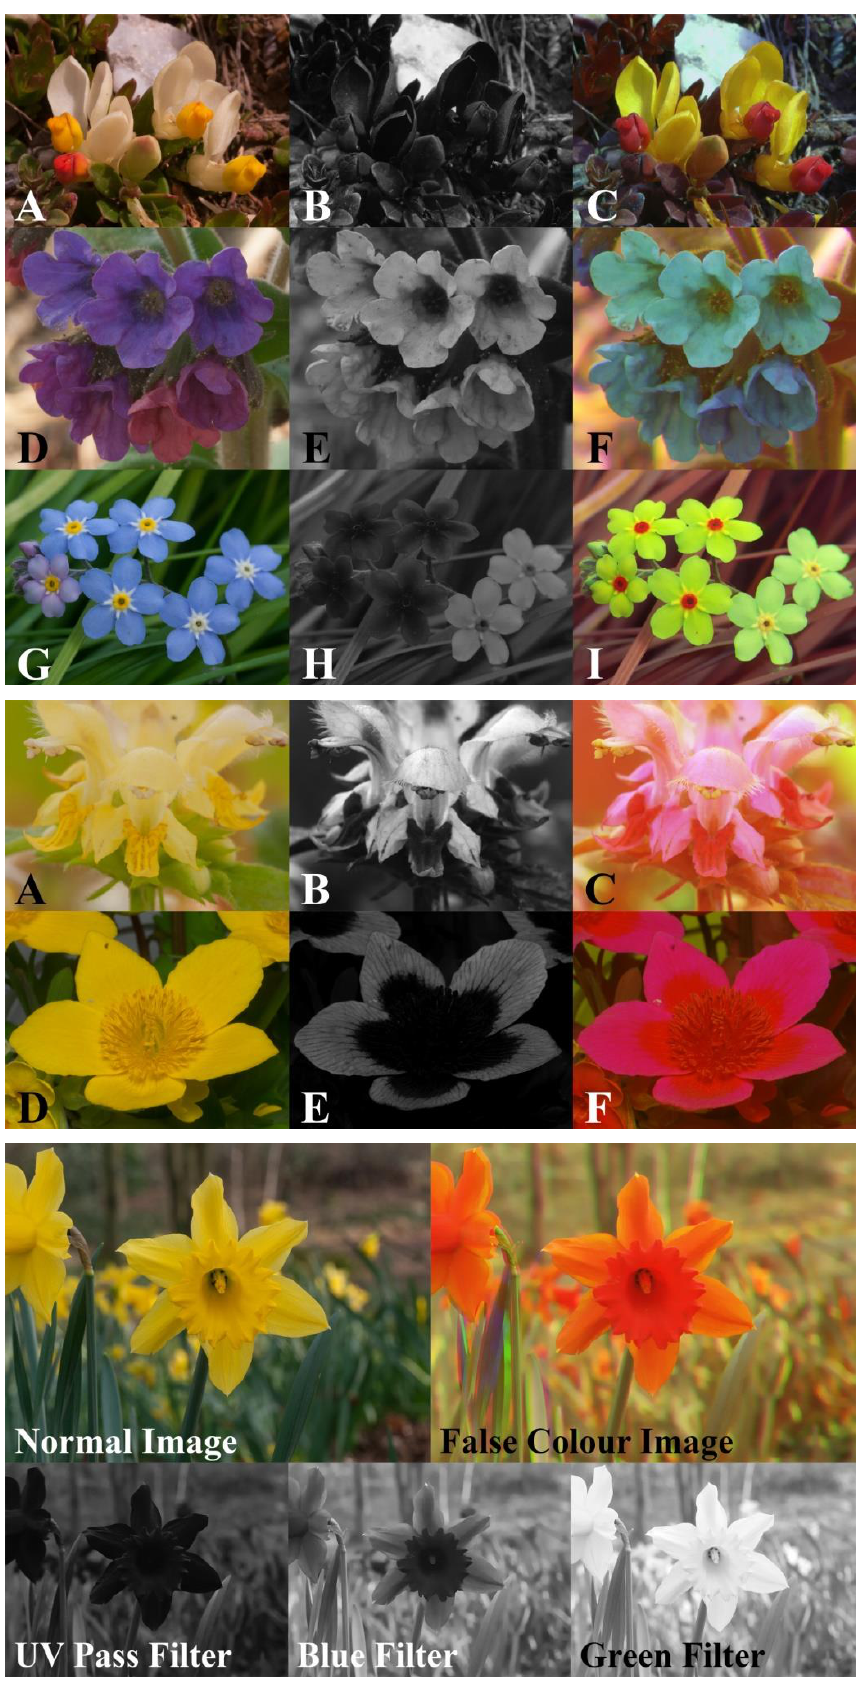
F IGURE 15: Colour picture, UV-picture and false-colour picture of Narcissus pseudonarcissuss L.. Additional pictures show the blue channel and the green